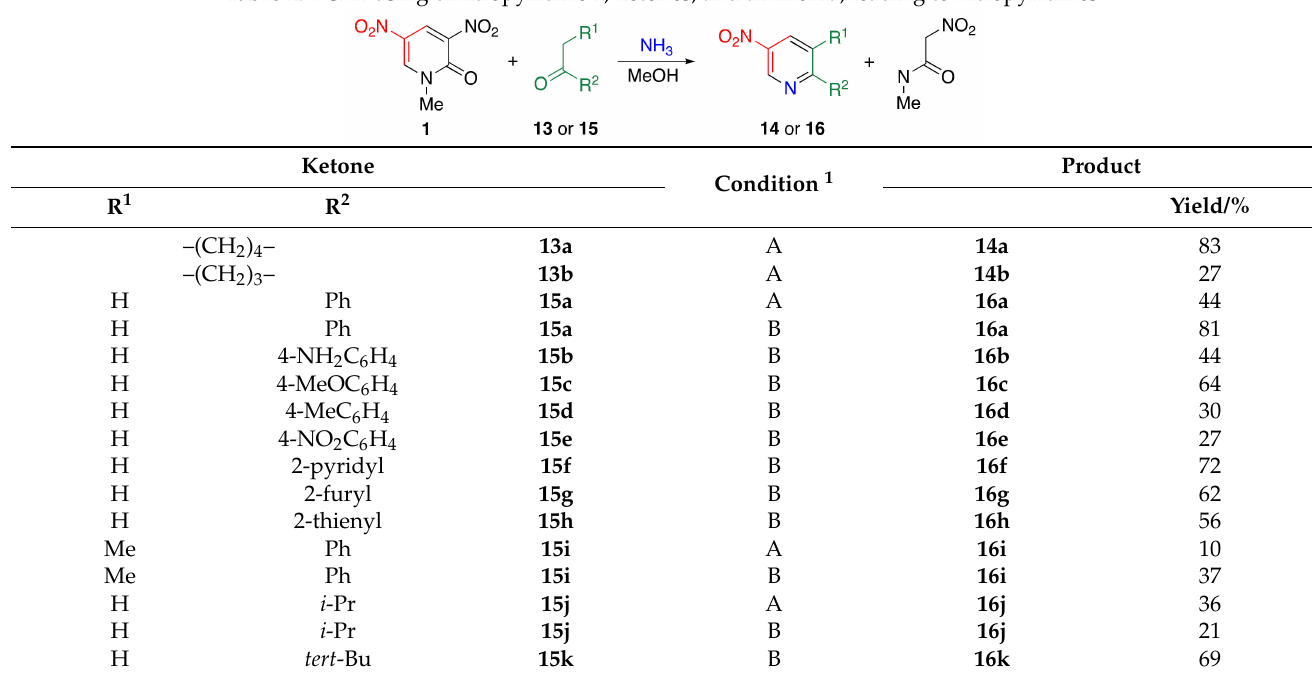
Table 2. TCRT using dinitropyridine 1 , ketones, and ammonia, leading to